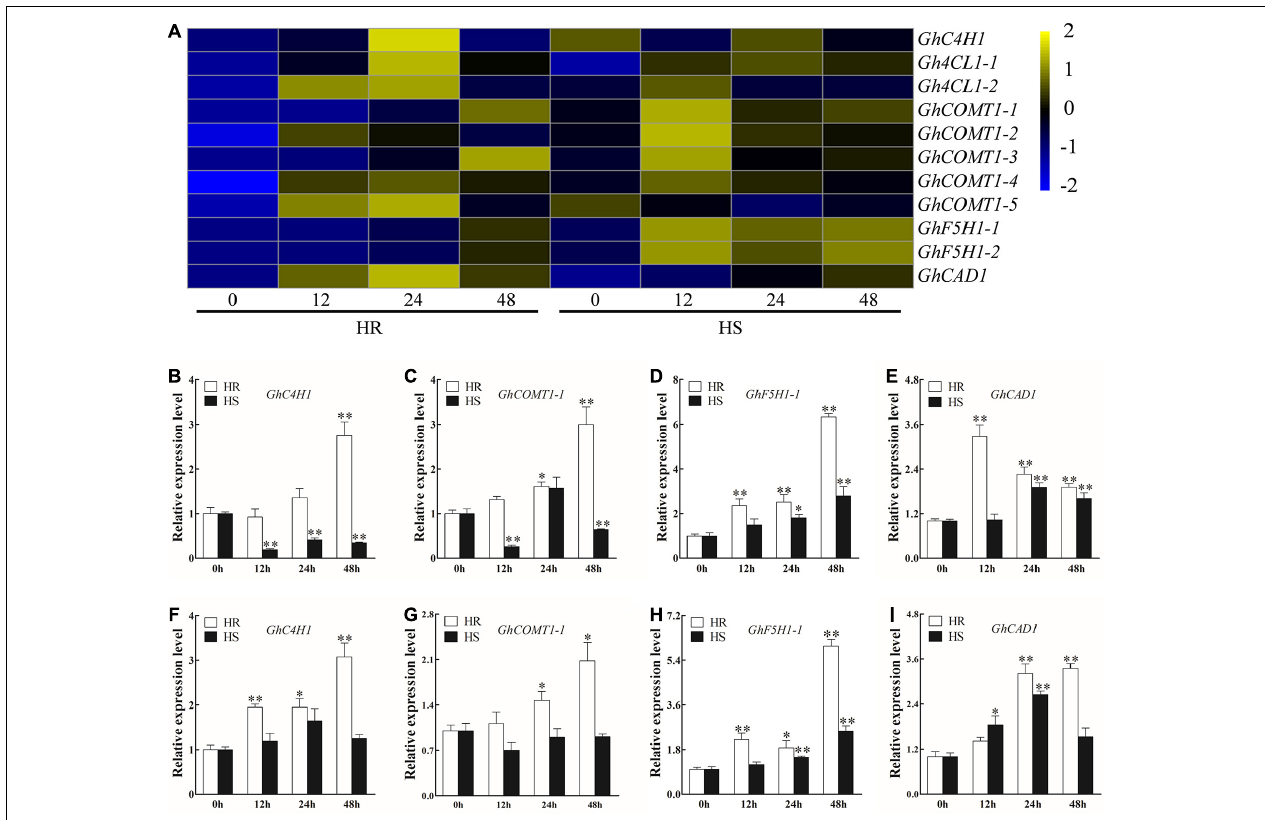
FIGURE 4 | Transcriptional profile of genes involved in lignin biosynthesis after Verticillium dahliae infection. (A) Heatmap showing the expression pattern of lignin biosynthesis-related genes in HR and Junmian 1 (HS) at 0, 12, 24, and 48 h post-inoculation (hpi). The heatmap was generated using fragments per kilobase of transcript sequence per million base pairs sequenced values normalized by Z-score. (B–E) Real-time quantitative PCR (RT-qPCR) analysis of lignin biosynthesis-related genes (B) GhC4H1 , (C) GhCOMT1-1 , (D) GhF5H1-1 , and (E) GhCAD1 in the roots of HR and HS at 0, 12, 24, and 48 hpi. (F–I) RT-qPCR analysis of lignin biosynthesis-related genes (F) GhC4H1 , (G) GhCOMT1-1 , (H) GhF5H1-1 , and (I) GhCAD1 in the stems of HR and HS at 0, 12, 24, and 48 hpi. For each cultivar, the expression level at each time point was compared with that at 0 hpi that was set to 1. Values represent mean ± SE of three independent biological replications (five individual plants per replicate). ∗ and ∗∗ represent significant differences from roots of the same cultivar at P < 0.05 and P < 0.01, respectively, based on Student’s t -test.